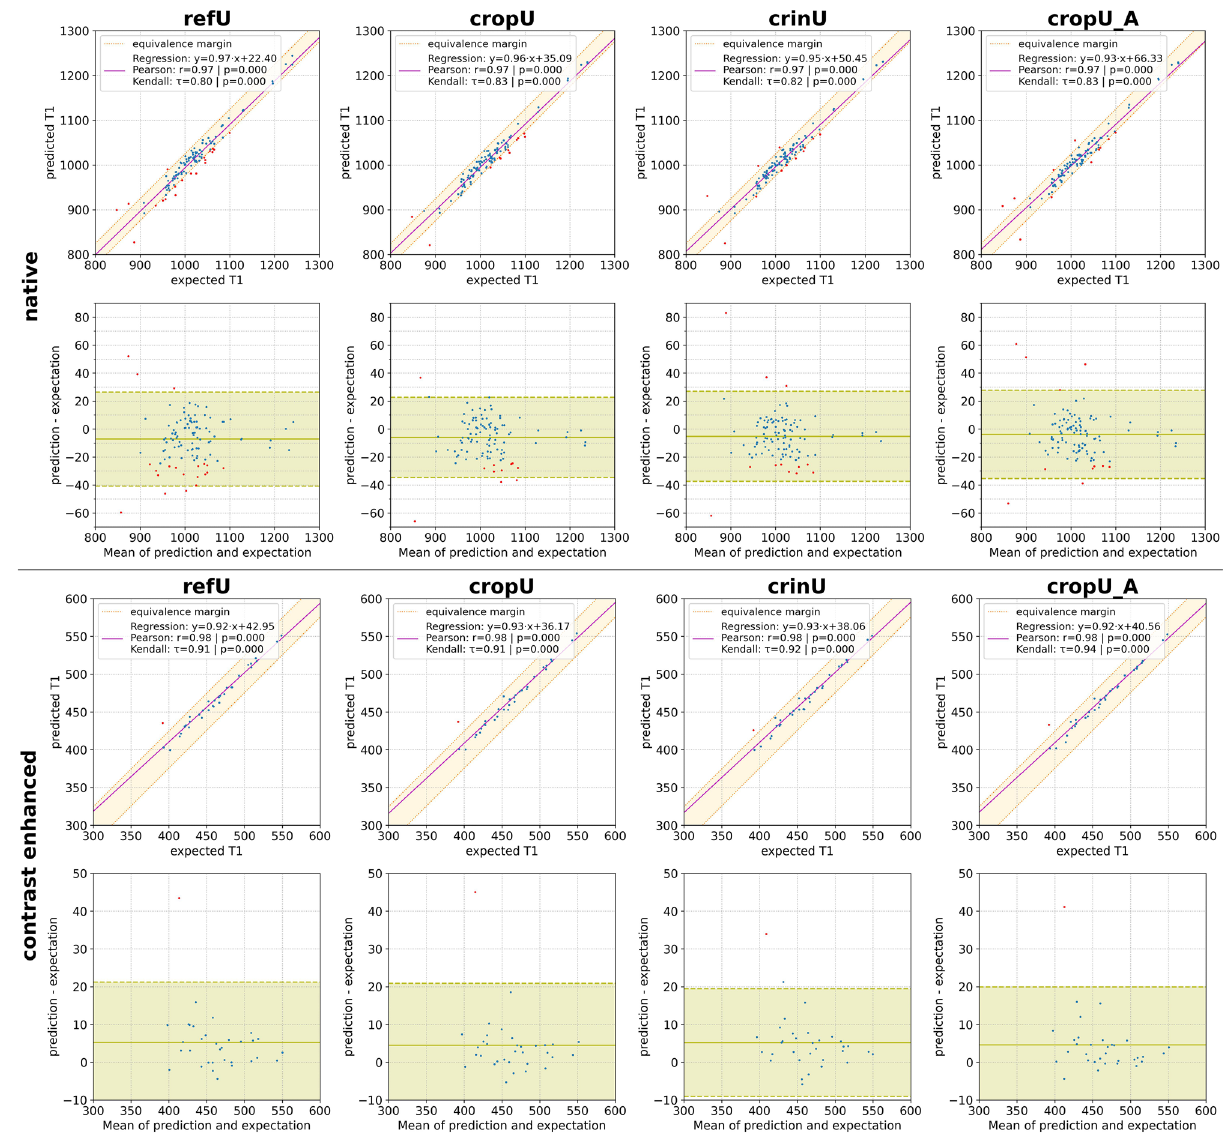
Figure 5. Quantitative results of the automated segmentation. The first column shows the quantitative results for refU, the second column for cropU, the third column for crinU and the fourth column for cropU_A. The upper block corresponds to native and the lower block to contrast enhanced data; respectively in each block the first row shows the correlation plot including the linear regression and the equivalence margin whereas the second row shows Bland–Altman-plots including the limits of agreement. Blue dots represent cases within the equivalence margin while red dots represent cases exceeding the equivalence